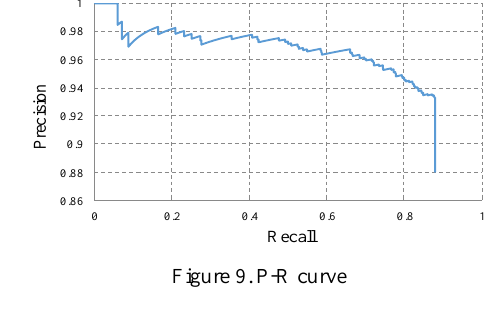
Table 2. Multi-scale feature maps generated by the model